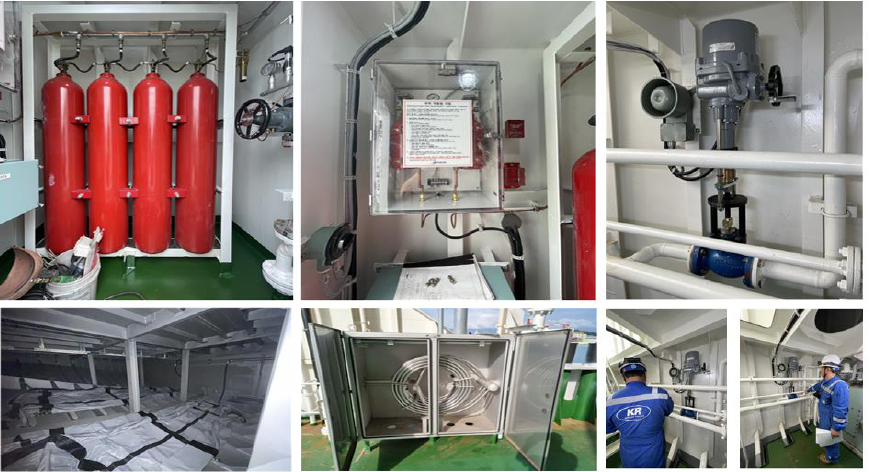
Figure 13. Prototype test ( above ) and target ship installation ( below ). Third-party verification certificate ( below right ) of the BSS.